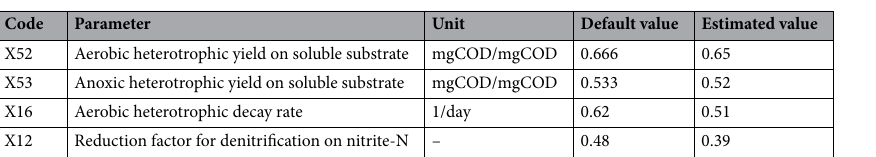
Table 5. Default and estimated values for identified influential